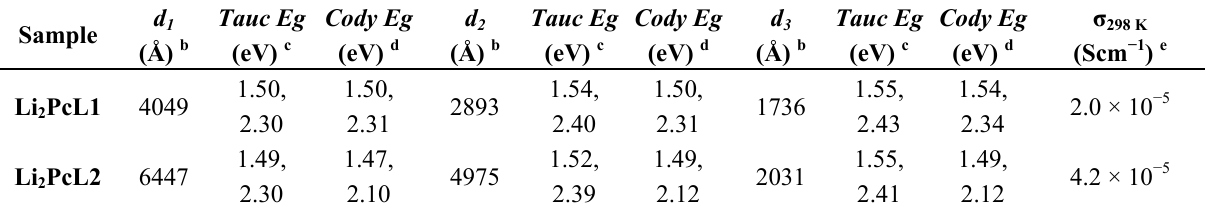
Table 2. Characteristic parameters of thin-films under investigation a